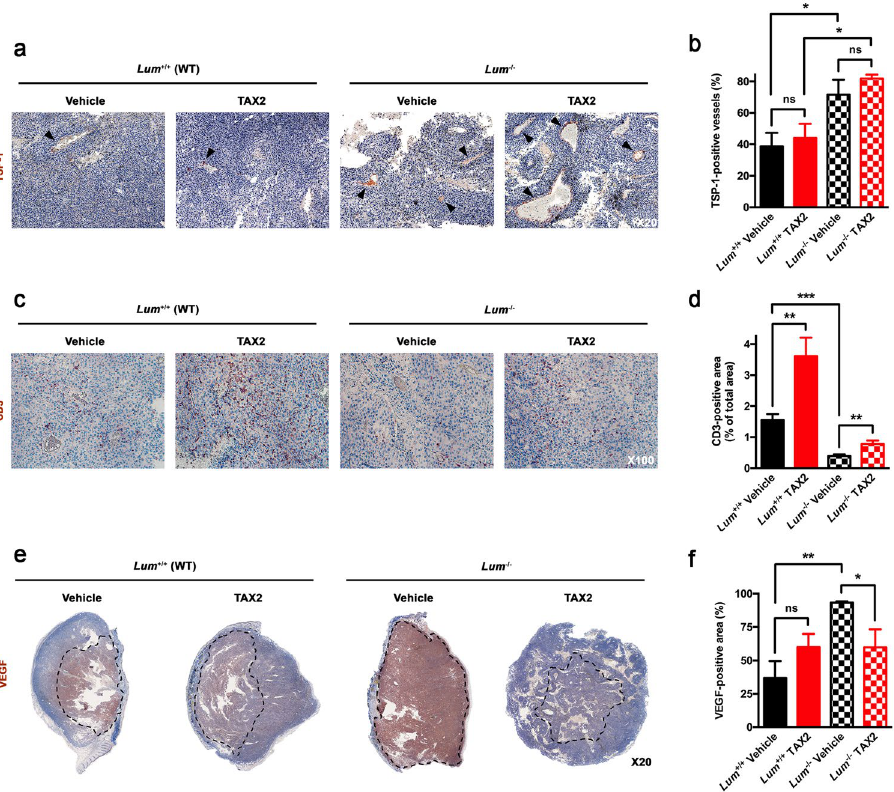
Figure 3. IHC analyses of s.c. melanoma allografts stromal features. ( a – f ) Microscopic views of tissue sections IHC allowing visualization of intratumoral ( a ) TSP-1 ( × 20, black arrowheads ), ( c ) CD3 ( × 100) and ( e ) VEGF ( × 20, dotted lines ) immunostainings and quantification of ( b ) percentage of TSP-1-positive blood vessels as well as relative ( d ) CD3-positive and ( f ) VEGF-positive areas (mean ± SEM, t test, ns not significant, * p < 0.05, ** p < 0.01, *** p < 0.001). All quantitative analyses were performed using ImageJ software. Five random